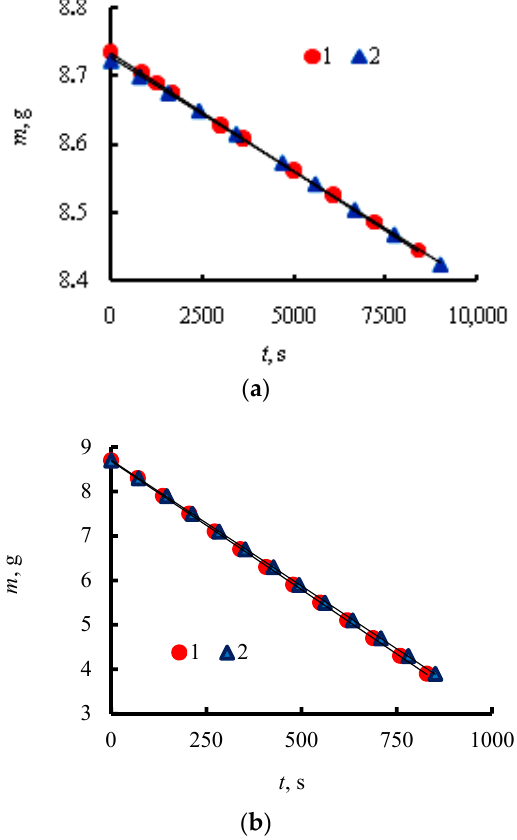
Figure 8. Evaporation of water layer (curve 1) and water layer with 10,000 ppm surfactant (curve 2) for layer diameter 40 mm and air humidity 30%: ( a ) T w = T a = 21 ° С , ( b ) T w = 90 ° С , T a = 21 ° С .